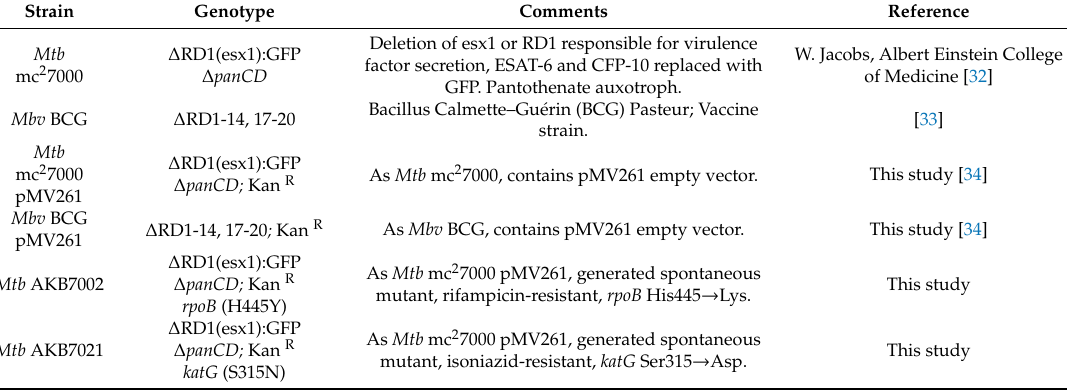
Table 2. Results of synthesis of the substituted amino acid hydrazides and the antibacterial activity and